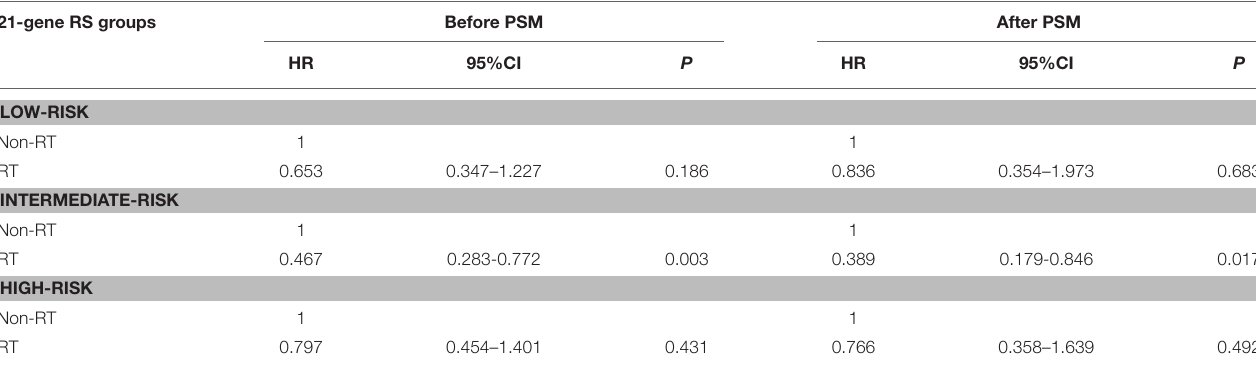
TABLE 3 | Multivariate prognostic analyses according to RS before and after propensity score matching. 21-gene RS